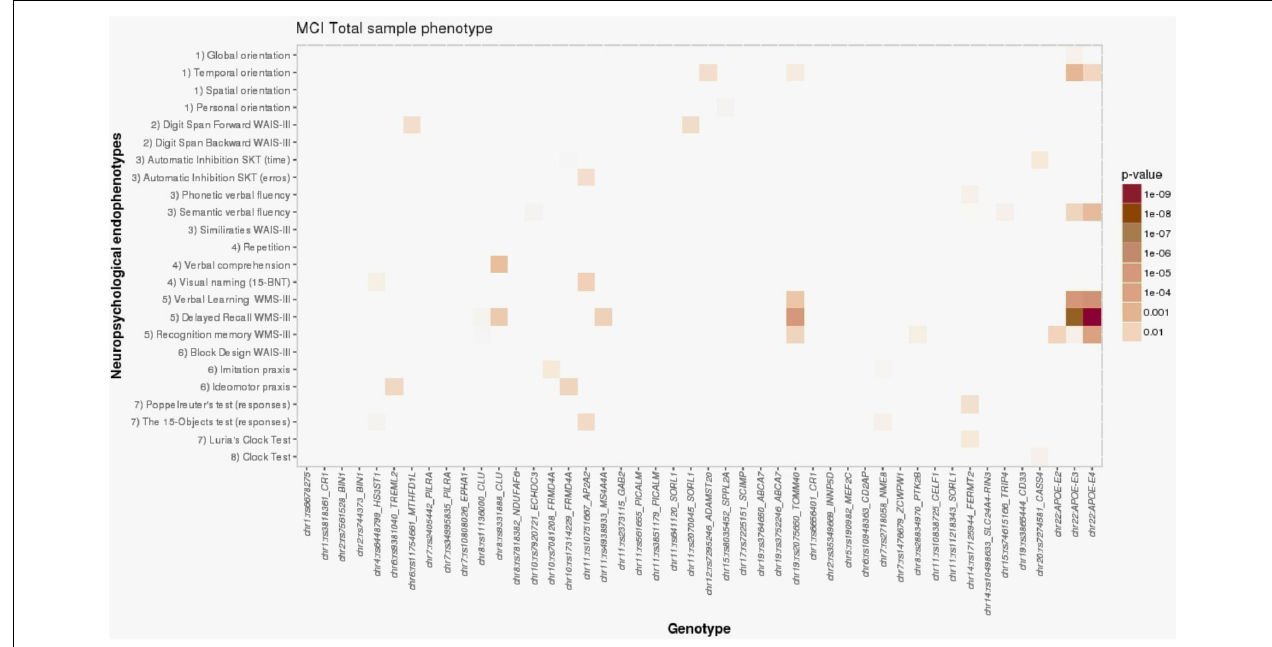
FIGURE 1 | Heat map visualization of associations between AD-associated SNPs and NEs of individuals with MCI, including (1) orientation, (2) attention and working memory, (3) processing speed and executive functions, (4) language, (5) verbal learning and memory, (6) praxis, (7) visual gnosis, and (8) global cognition. Global orientation, summary of temporal + spatial + personal orientations; WAIS-III, Wechsler adult intelligence scale, third edition; SKT, Syndrome Kurz test; 15-BNT, the abbreviated Boston naming test with 15 items; verbal learning WMS-III, 1st + 2nd + 3rd + 4th trial scores; WMS-III, Wechsler memory scale, third